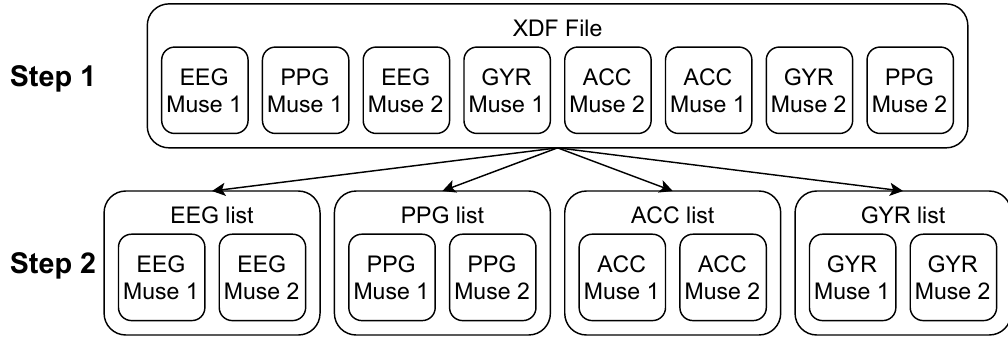
Figure 2. Example of XDF file conversion into separate